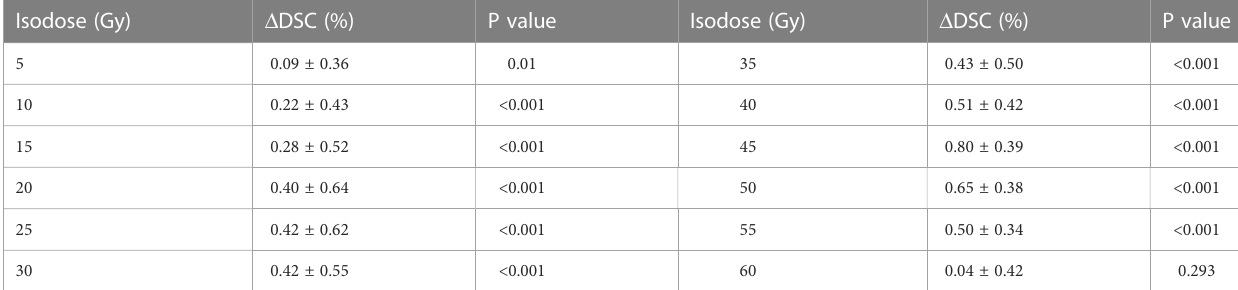
TABLE 3 Statistical comparison of the mean DSC values of the isodose volumes between the two models. Isodose